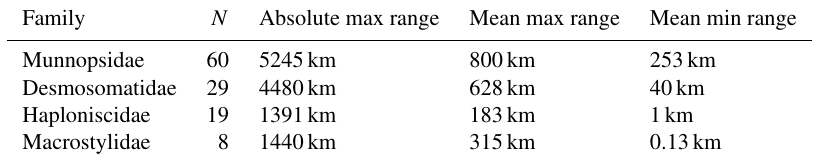
Table 5. Species distribution range by family. Data show the maximum distribution range of the species of each family excluding singletons.